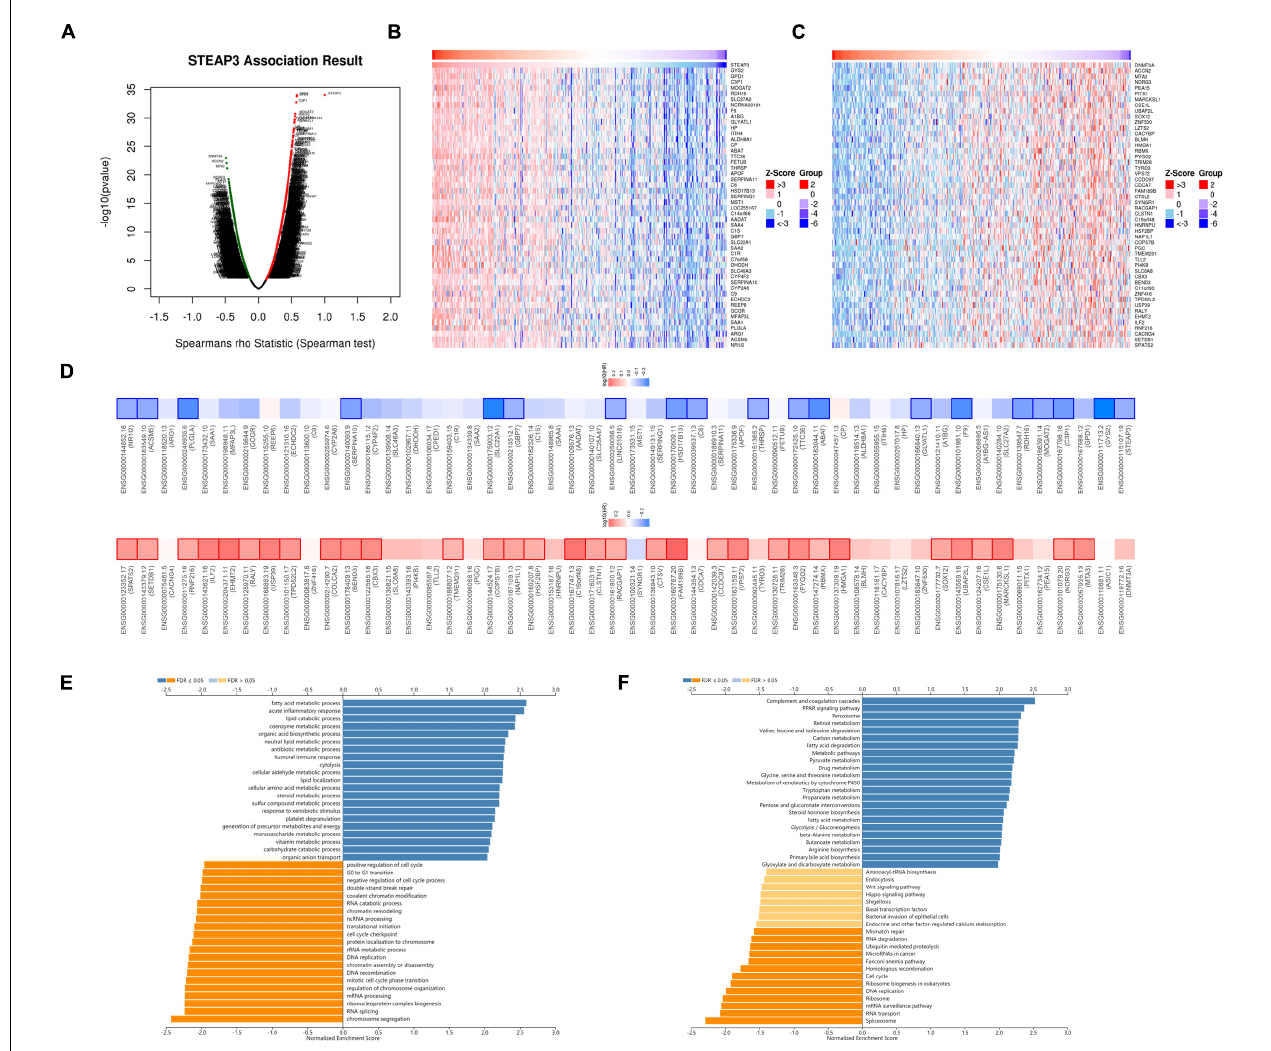
FIGURE 5 | The co-expression genes of STEAP3 in LIHC. (A) The whole significantly correlated genes with STEAP3 identified with LinkedOmics in LIHC. (B,C) The top 50 genes displaying positive and negative association with STEAP3 in LIHC were showed in heatmaps respectively. The red represented positively connected genes and the blue meant negatively connected genes, respectively. (D) Survival heatmaps exhibited the top 50 genes bearing positive and negative correlation with STEAP3 in LIHC. (E,F) GO annotations as well as KEGG pathways of STEAP3 in LIHC